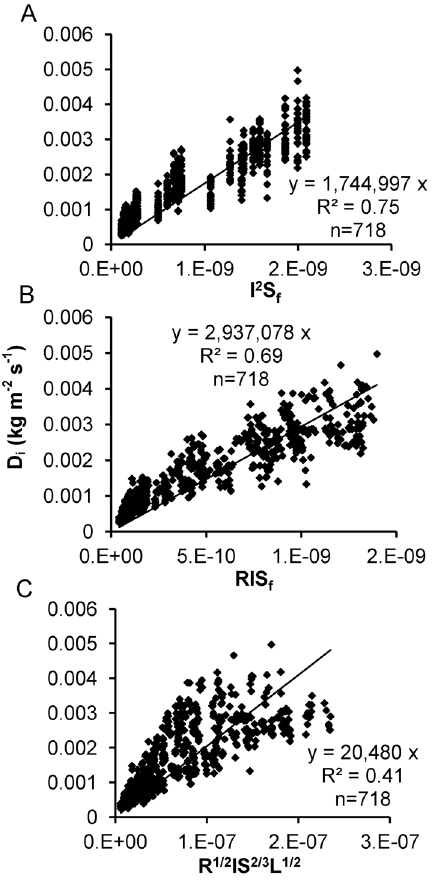
Figure 1. Linear regressions with zero intercept. Using linear regression with zero intercept between interrill erosion rate and the scaling factors I 2 S f (A), RIS f (B), and IR 1/2 S 2/3 L 1/2 (C) to assess the previous interrill equations based on the mini plots.